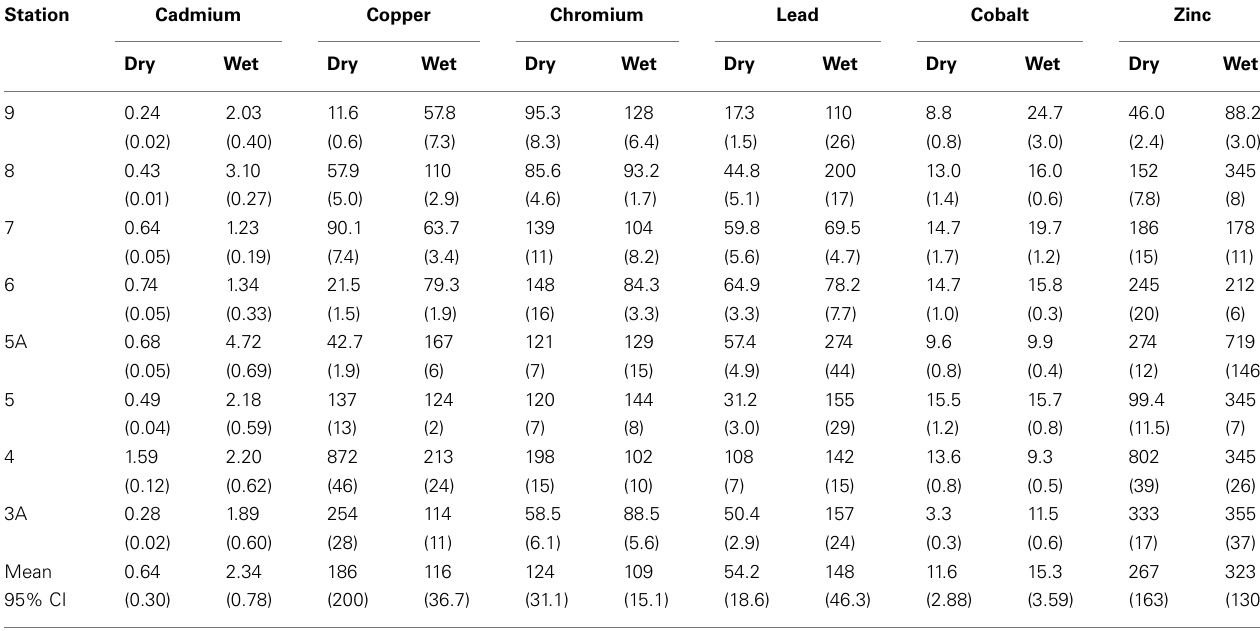
TableA5 | Heavy metal levels in sediments along theAlmendares River in µ g/g.